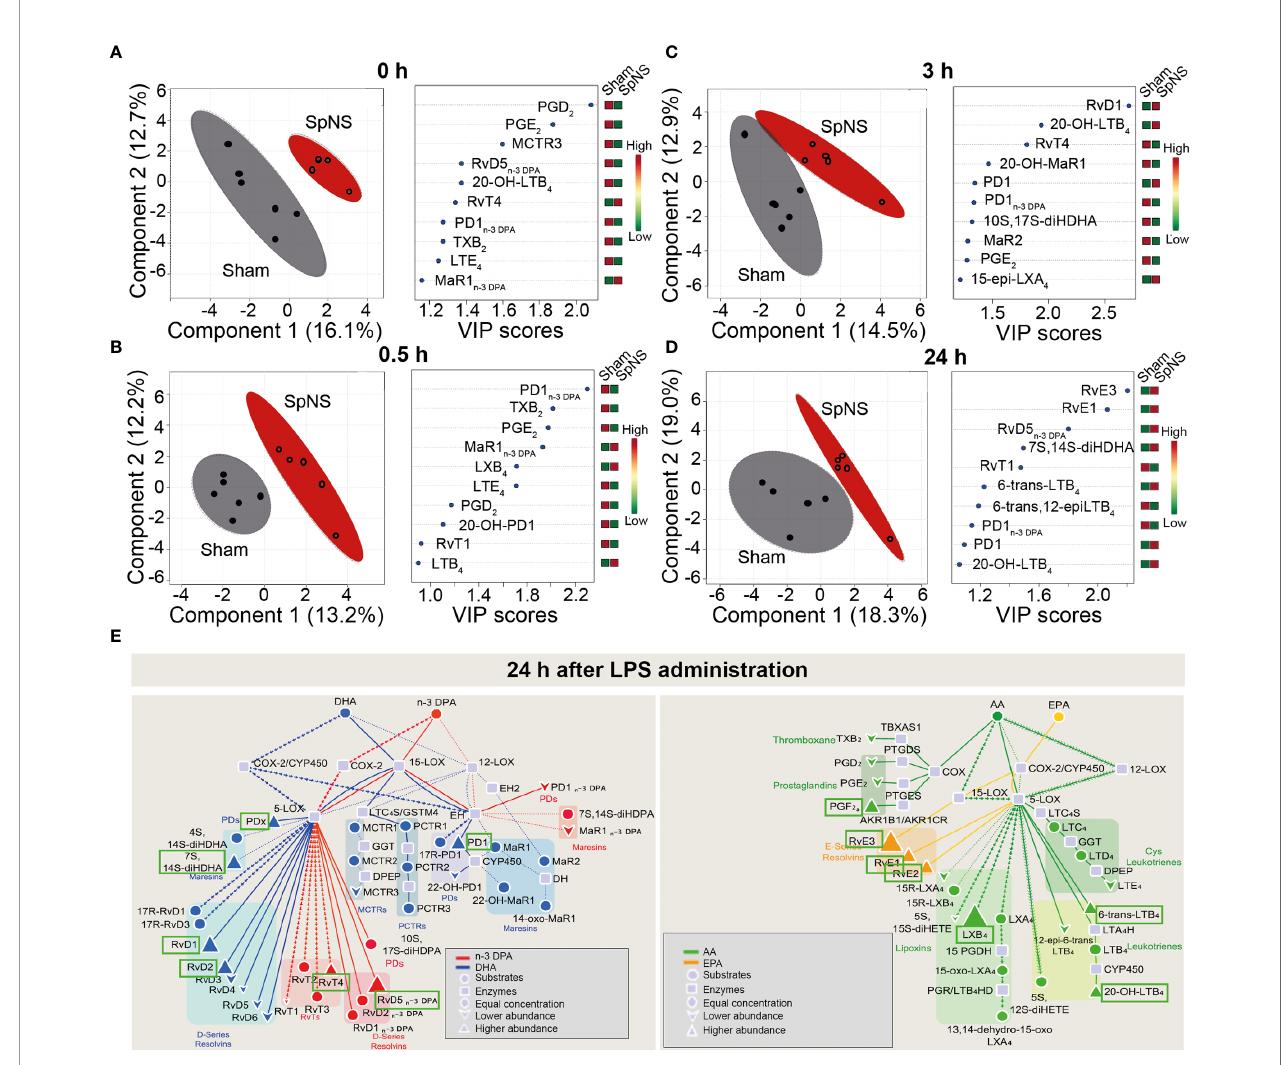
FIGURE 5 | Chronic SpN Neuromodulation reprograms peripheral blood lipid mediator pro fi les. Porcine splenic nerve was stimulated chronically for 8 days. Plasma was collected immediately prior to LPS challenge (A) , 0.5 (B) , 3 (C) and 24 (D) h post LPS challenge and lipid mediators were investigated using LC-MS/MS-based pro fi ling. Results were interrogated using Partial Least Square Discriminant Analysis. (Left panels) Display Score Plots. Colored area represents the 95% interval con fi dence. (Right panels) Plots displaying the lipid mediators with the 10 highest VIP scores from component 1. n = 5 for Sham group and n = 6 for SpNS group. (E) Flux down each of the bioactive metabolomes was assessed in the samples collected 24h post LPS injection. Pathway analysis for the differential expression of mediators from the DHA and n-3 DPA (left panel) and EPA and AA (right panel) bioactive metabolomes in SpNS group when compared to Sham group. Results are expressed as the fold change. Green boxes indicate the SPMs upregulated in the SpNS group at 24h post LPS (vs Sham). n = 5 for Sham group and n = 6 for SpNS